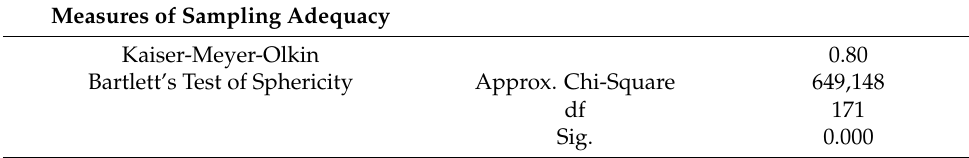
Table 7. Measures of Sampling Adequacy.